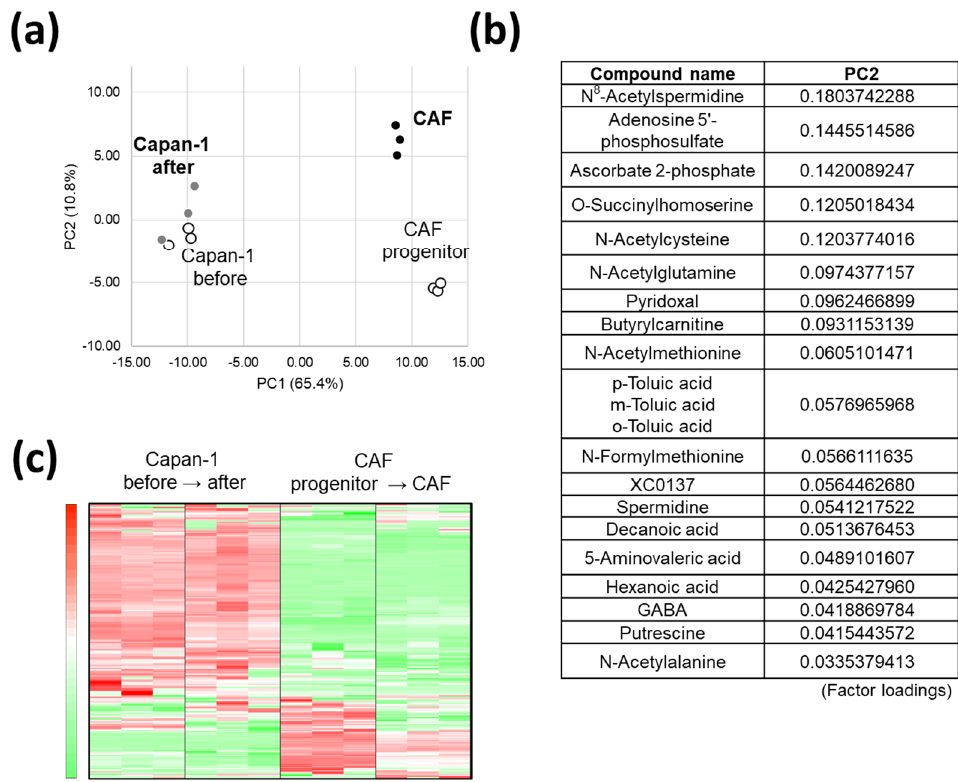
Figure 2. Global trend of metabolite changes in cancer cells (Capan-1 cells) and cancer-associated fibroblasts (CAFs): ( a ) Principal component analysis (PCA) of metabolomic datasets of Capan-1 cells and CAFs grown in a non-contact transwell co-culture; ( b ) The metabolites involved in PC2-axis and their contribution rates; ( c ) Heat map comparing altered metabolites between Capan-1 cells ( n = 3) and CAFs ( n = 3).